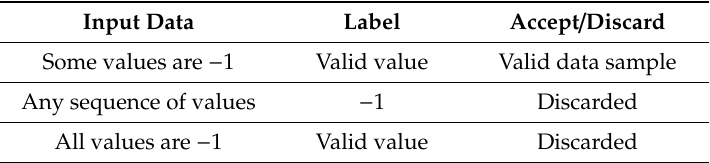
Table 3. Handling of missing data in neural